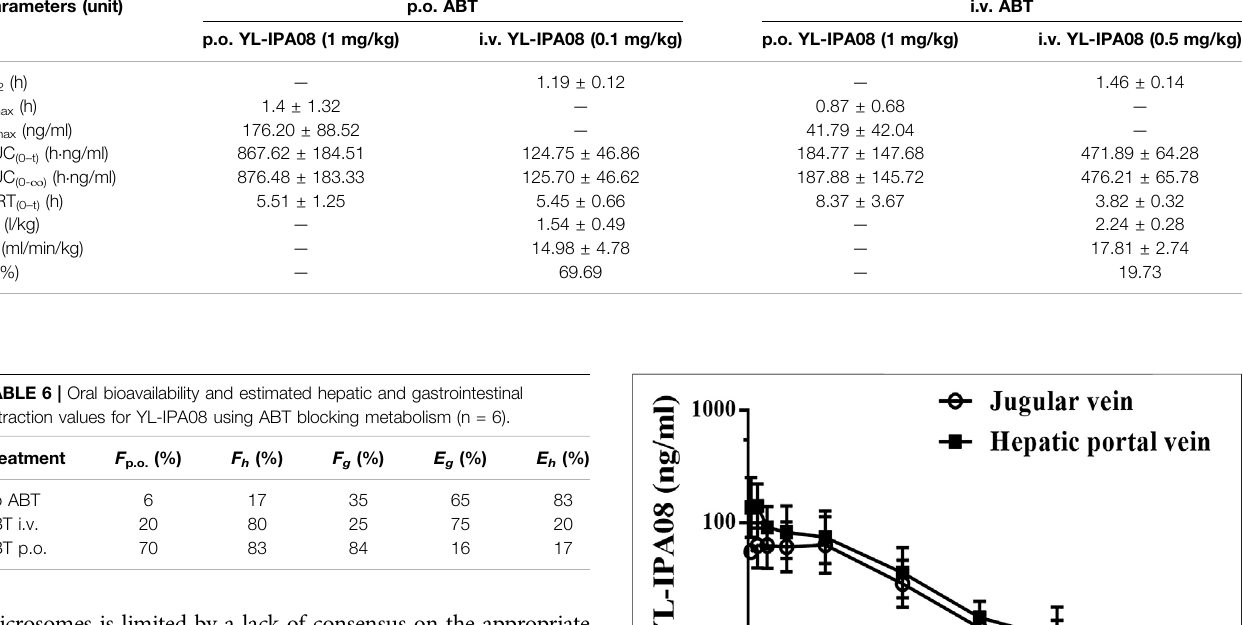
TABLE 5 | Pharmacokinetic parameters of YL-IPA08 in rats after intravenous and oral combination with ABT (n (cid:2) 6). Parameters (unit)